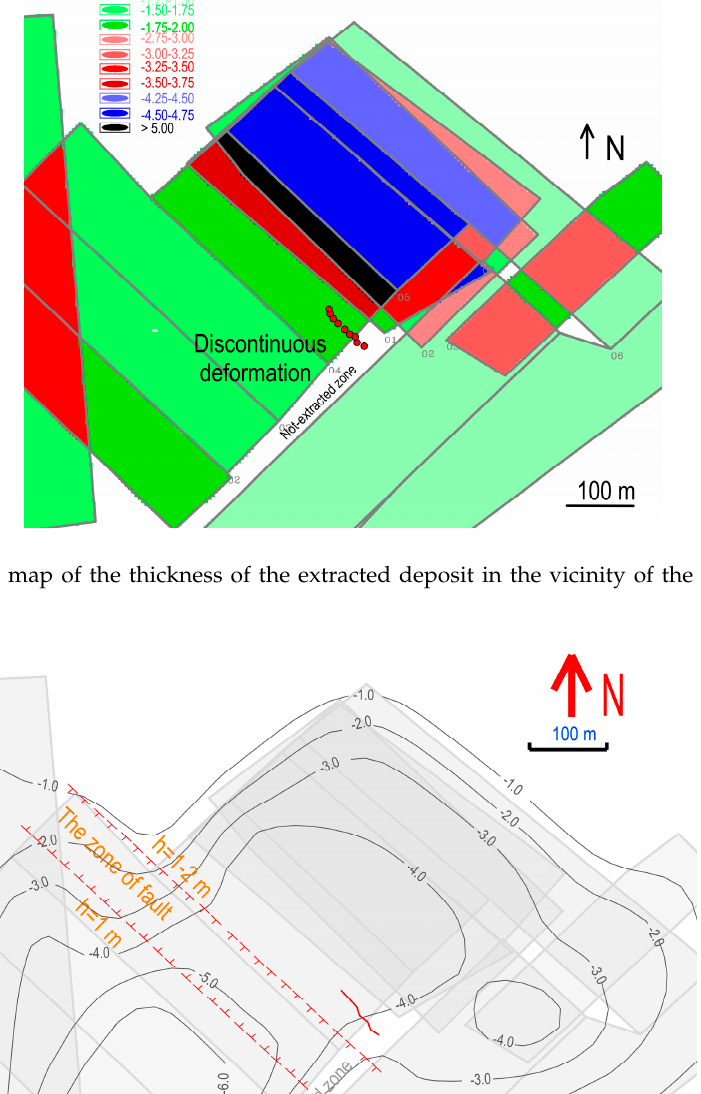
Figure 12. The distribution of the final maximum horizontal strain values in the vicinity of the discontinuous deformation (values in m/mm). As seen in Figure 10, the deformation was formed in the vicinity of an area separating the fields characterized by the highest and lowest thicknesses of the selected deposit. Moreover, it should be noted that in the area of the tectonic fault, the deposit was extracted very unevenly. A much higher mean thickness of the deposit was extracted on the side of the hanging-wall (over 5 m) than on the side of the footwall (2 m). On the basis of Figure 11, it can be concluded that the maximum values of subsidence of ca. 7 m occurred to the west of the deformations. In the deformation area, the subsidence amounted to ca. 4.2 m. Therefore, it should be concluded that significant values of subsidence occurred in the area of the discontinuous deformations.